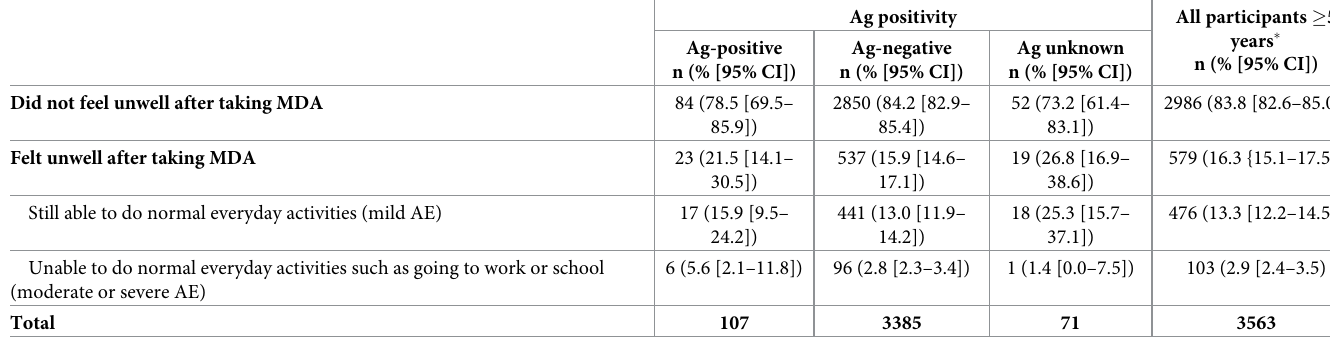
Table 3. Reported adverse events by antigen